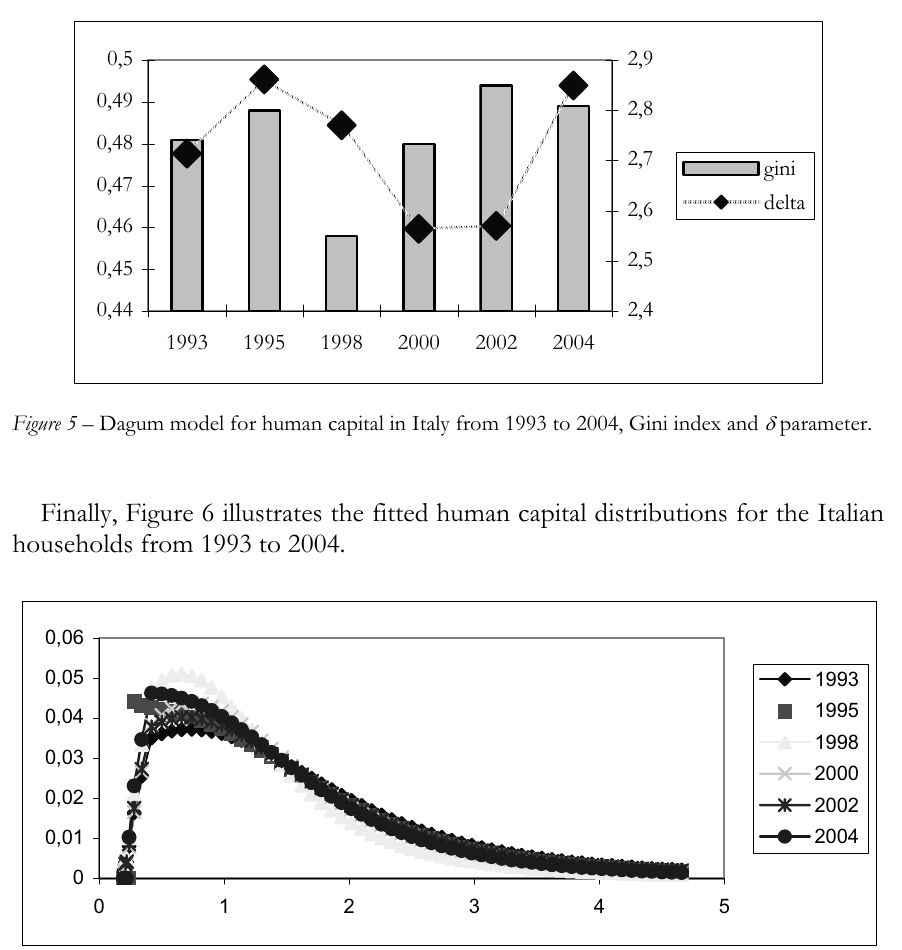
Figure 6 – Dagum four parameter model for human capital of Italian households from 1993 to